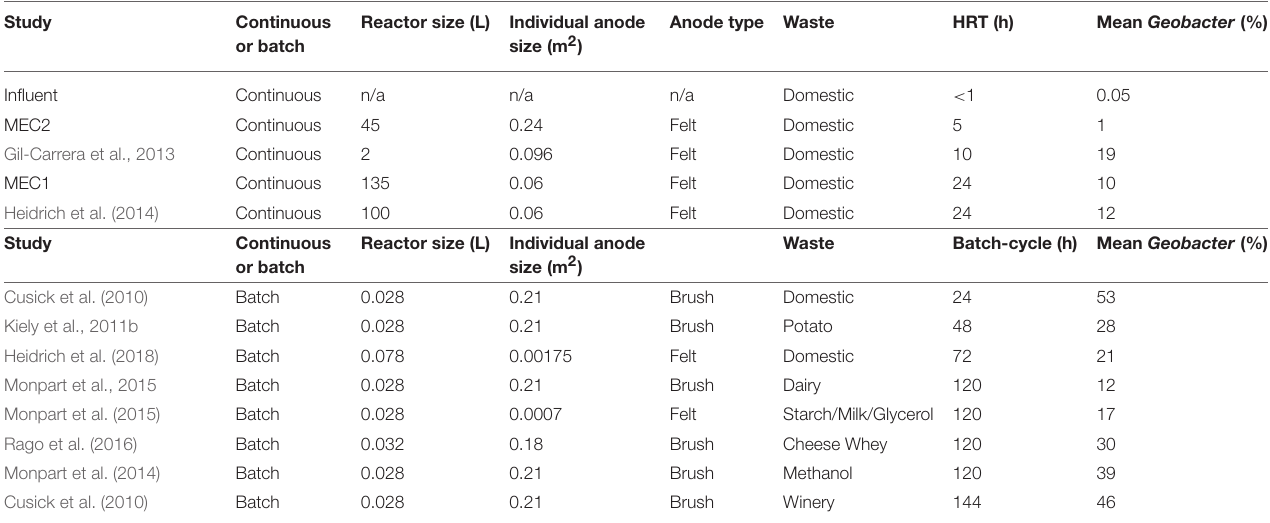
TABLE 1 | Experimental conditions of the MEC anodes fed real wastewater shown in Figure 3